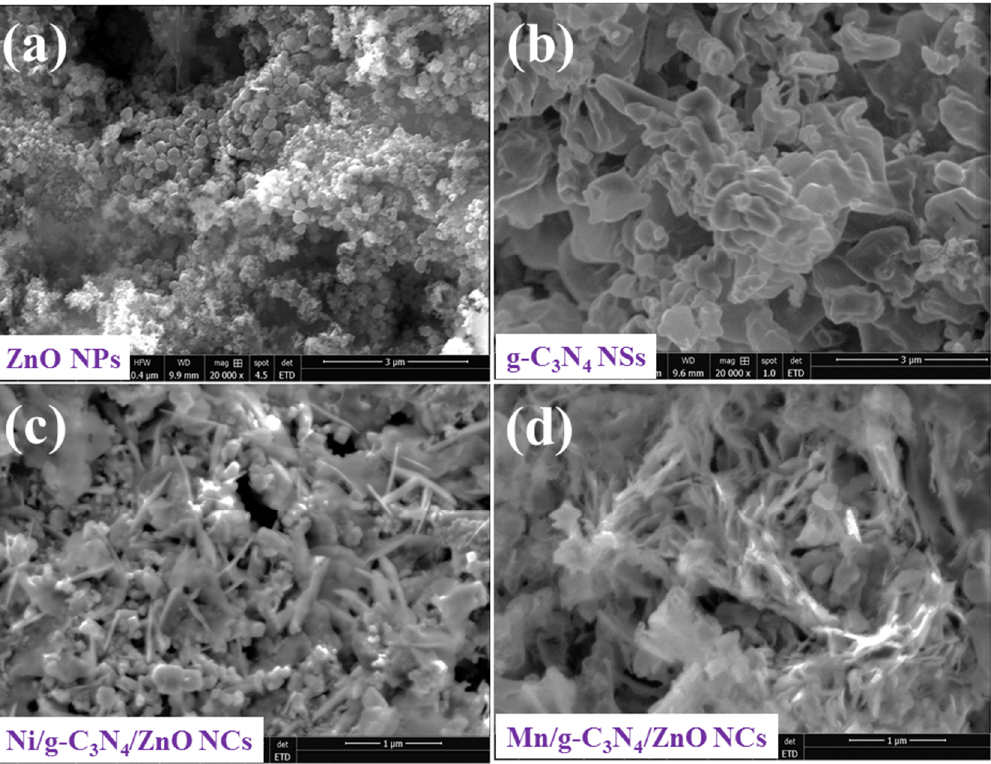
Figure 5. Morphological analysis of ZnO ( a ), g-C 3 N 4 ( b ), Ni/g-C 3 N 4 /ZnO ( c ), and Mn/g-C 3 N 4 /ZnO ( d ) by SEM.